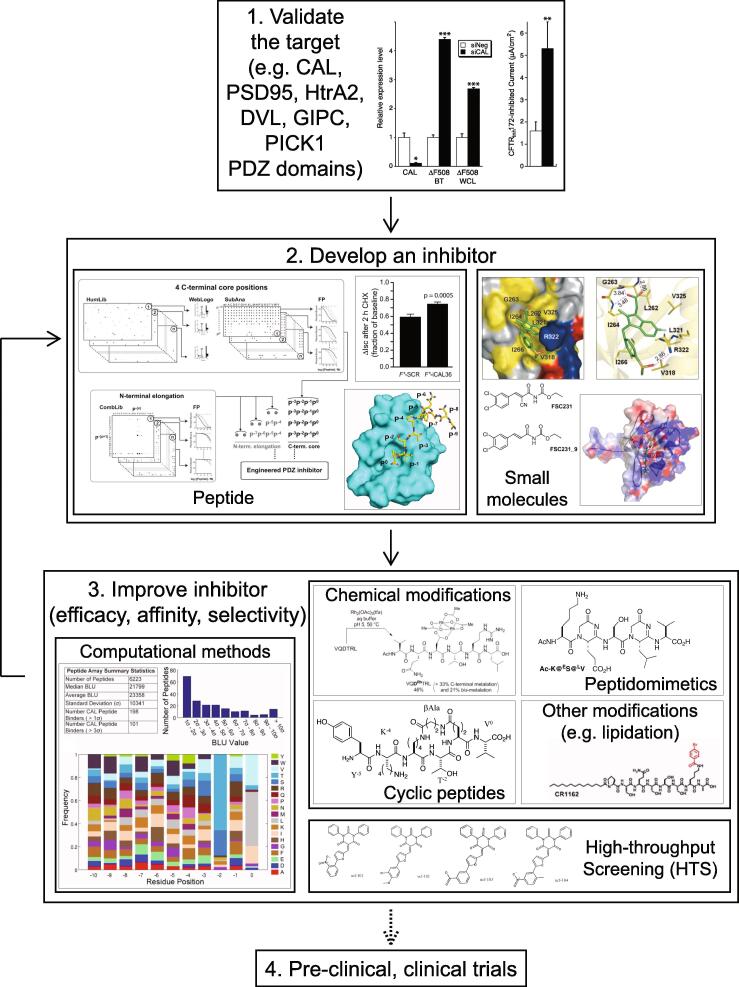
Drug development pipeline for PDZ domain inhibitors. A general pipeline is shown for target validation, inhibitor development, and inhibitor refinement for select PDZ domain inhibitors, as assessed by a literature review. Figures have been adapted from references as follows: top panel (Wolde et al., 2007); middle panel (Amacher et al., 2013, Cushing et al., 2010, Lee et al., 2009, Thorsen et al., 2010, Vouilleme et al., 2010); bottom panel (Cilenti et al., 2003, Hammond et al., 2006, Kundu et al., 2012, Patra et al., 2012, Piserchio et al., 2004, Roberts et al., 2012).